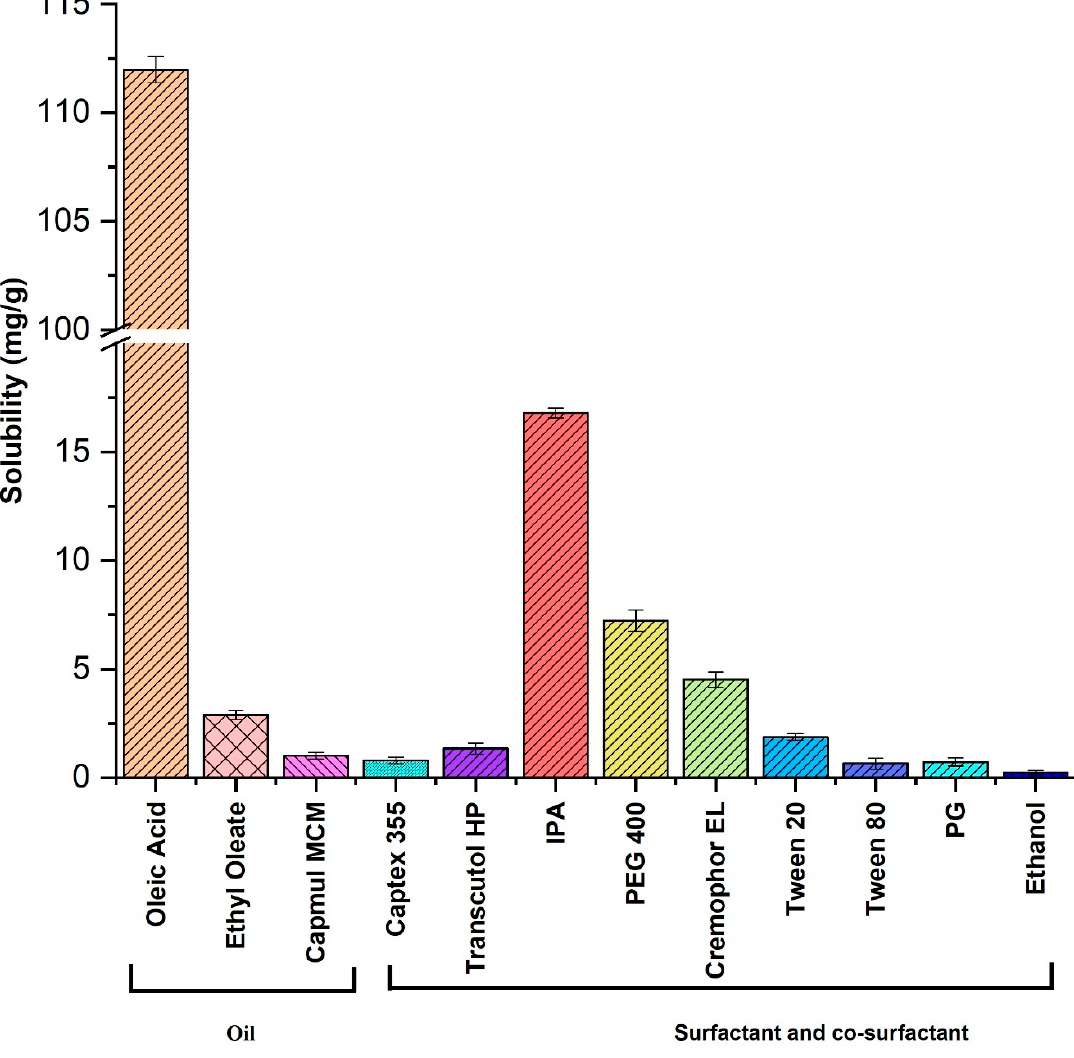
Figure 2. Imiquimod solubility in different oils, surfactants, and co-surfactants ( n = 3). Solubility of imiquimod in oleic acid is significantly ( p < 0.05) high compared with other oils, surfactants, and co-surfactants.